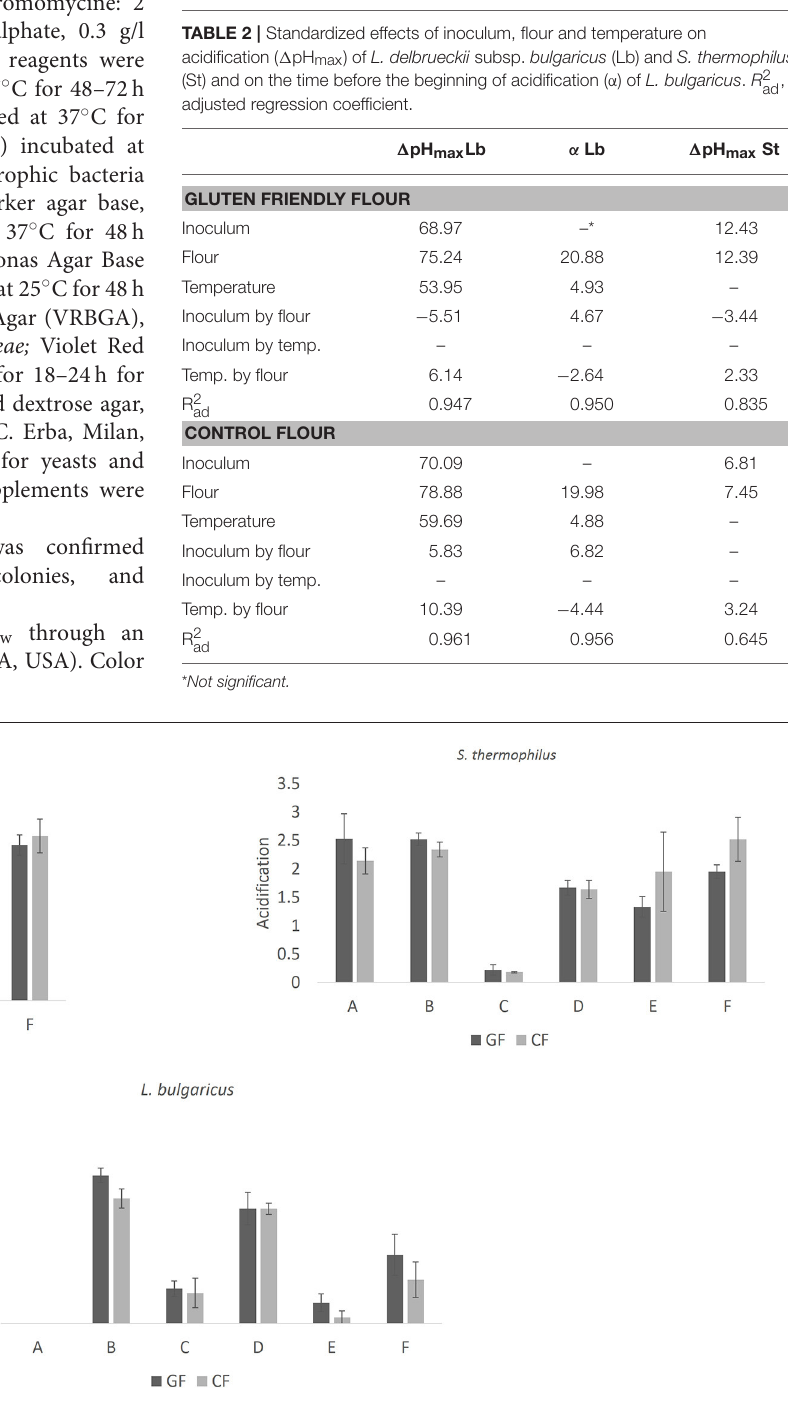
FIGURE 2 | Parameters (mean values ± standard error) of the lag-exponential model for L. delbrueckii subsp. bulgaricus and S. thermophilus in the combinations of the design. Acidification: parameter 1 pH max ; lag phase: parameter α . GF, Gluten Friendly Flour; CF, Control Flour.